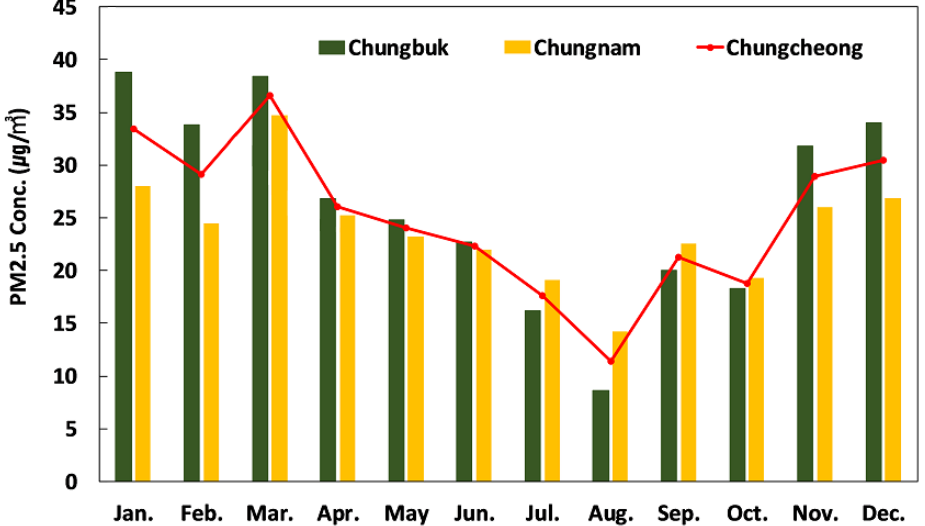
Figure 6. The 2017 monthly mean PM 2.5 concentration in Chungcheong .